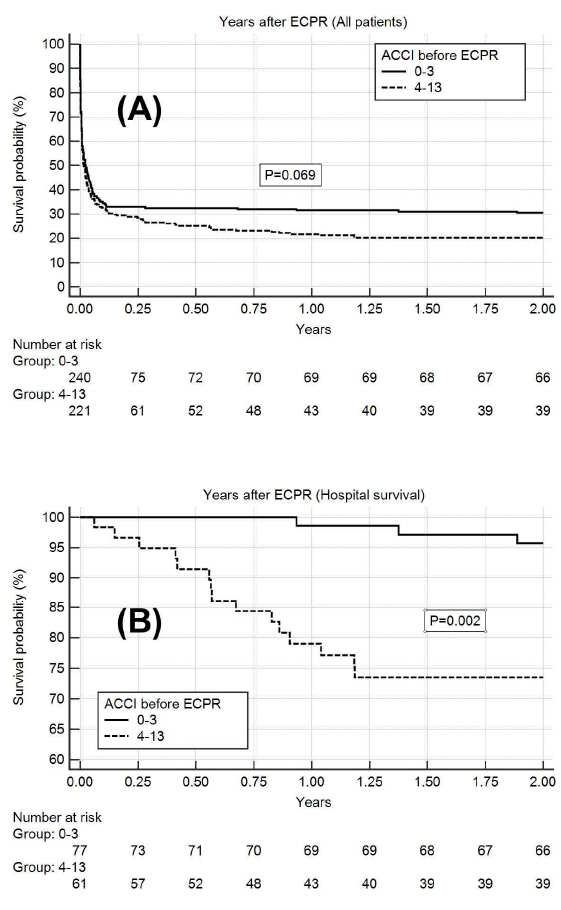
Figure 4. Kaplan–Meier analysis for a 2-year survival rate, with patients grouped by age-adjusted Charlson comorbidity index (ACCI) before extracorporeal cardiopulmonary resuscitation (ECPR). ( A ) Kaplan–Meier survival analysis for all patients, which shows the marginal 2-year survival advantage for ACCI 0–3 patients (0.31, standard error (S.E) of 0.03), compared with that for ACCI 4–13 patients